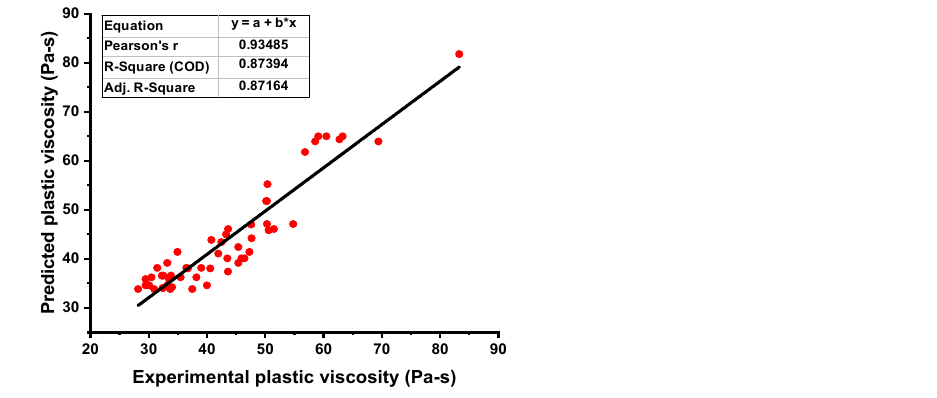
Figure 7. Plastic viscosity relationship for the actual and predicted result of the NN model.